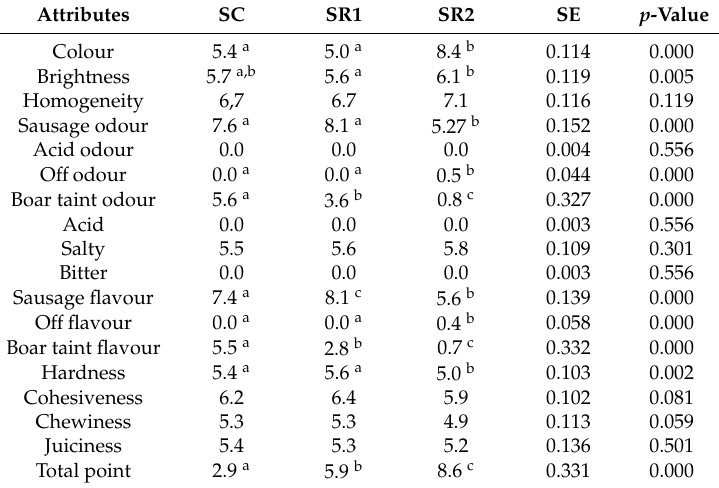
Table 6. Sensory analyses LSM +/ - SE of Spanish